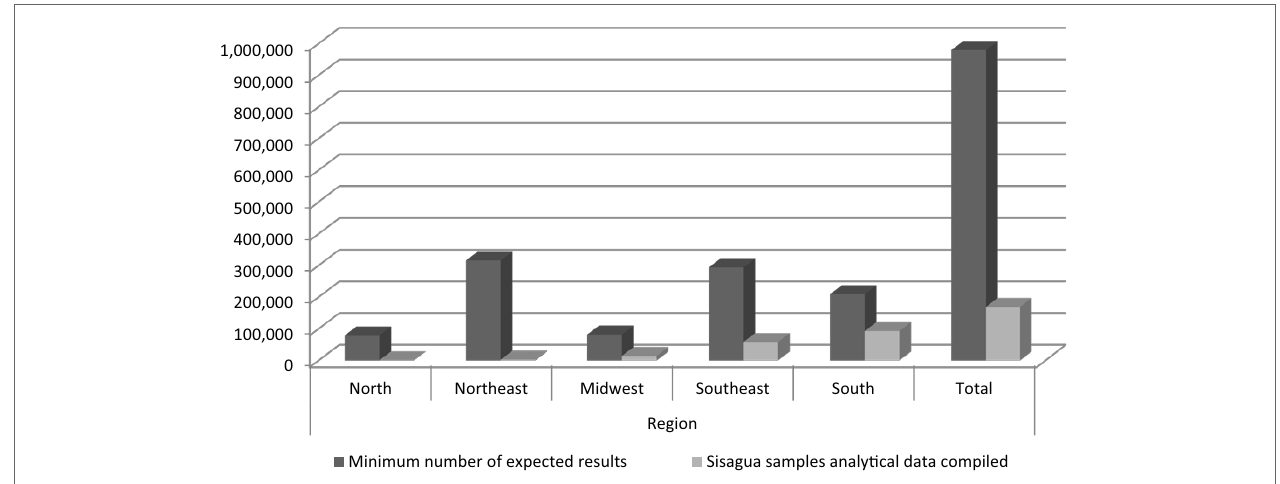
FigUre 1 | The expected and actual number of pesticides analyses informed by each Brazilian region in sisagua from 2007 to 2010